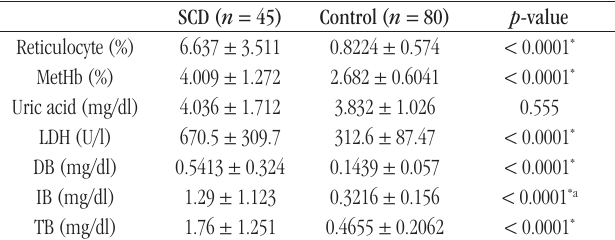
taBLE 2 − Concentration of reticulocytes, MetHb, uric acid, LDH, and bilirubin (BT, BD, and BI) in patients with SCD and the control group